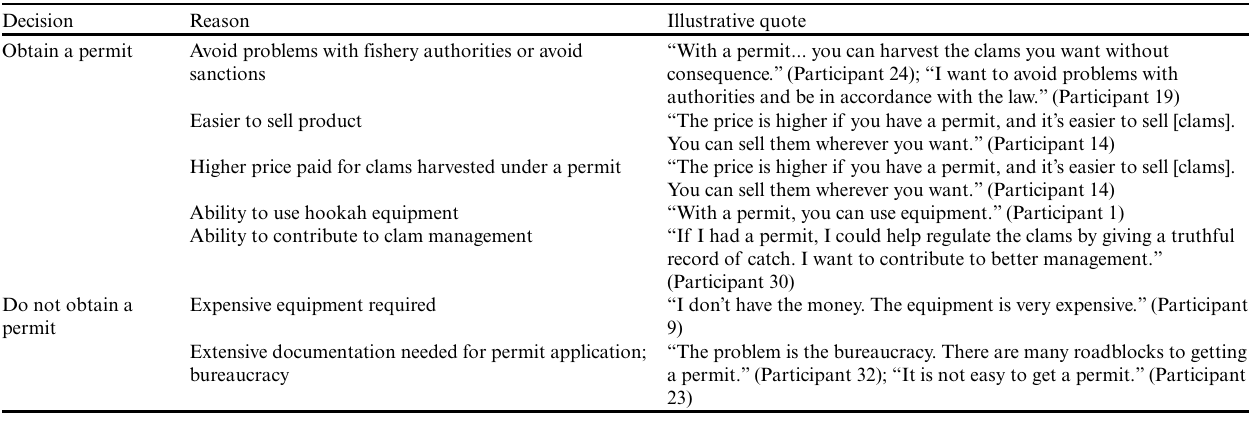
Table 3. Primary reasons affecting fishers’ decisions to obtain or not to obtain a species-specific fishing permit for the Mexican chocolate clam. Reason categories emerged from participants’ responses to an interview question about what factors affect their decision to obtain or not to obtain a fishing permit for this